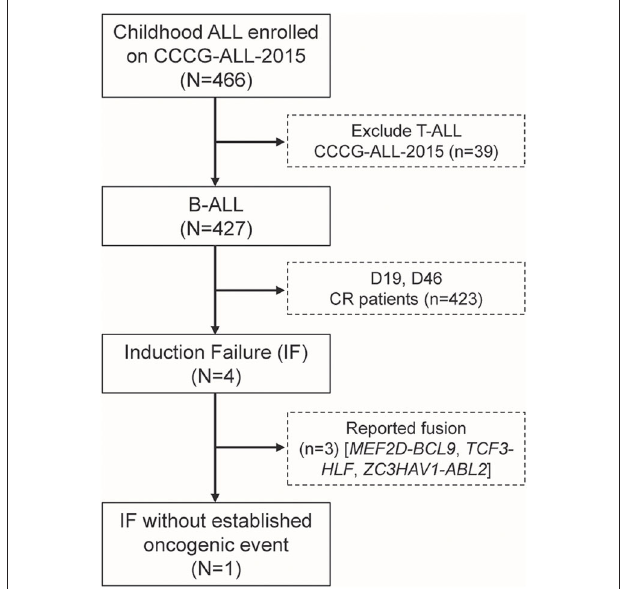
FIGURE 1 | Identification of one induction failure B-ALL case without known fusion gene among patients enrolled onto CCCG-ALL-2015 in Guangzhou Women and Children’s Medical